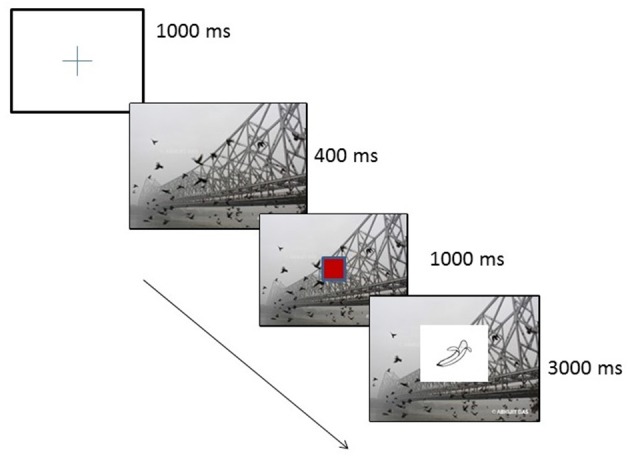
Sample trial showing sequence of events.